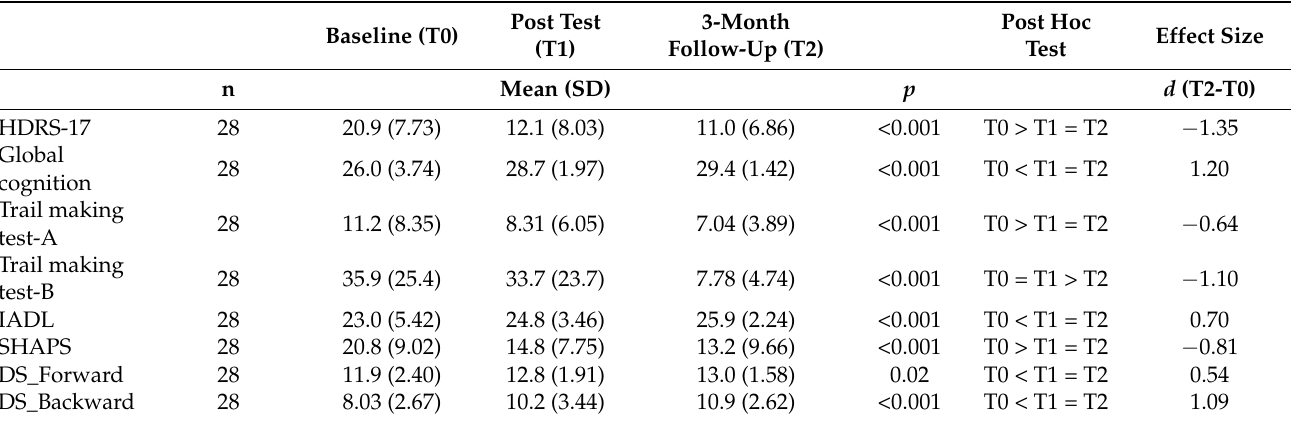
Table 4. The differences in the primary and secondary outcomes between baseline, post-test, and at the 3-month follow-up (n =